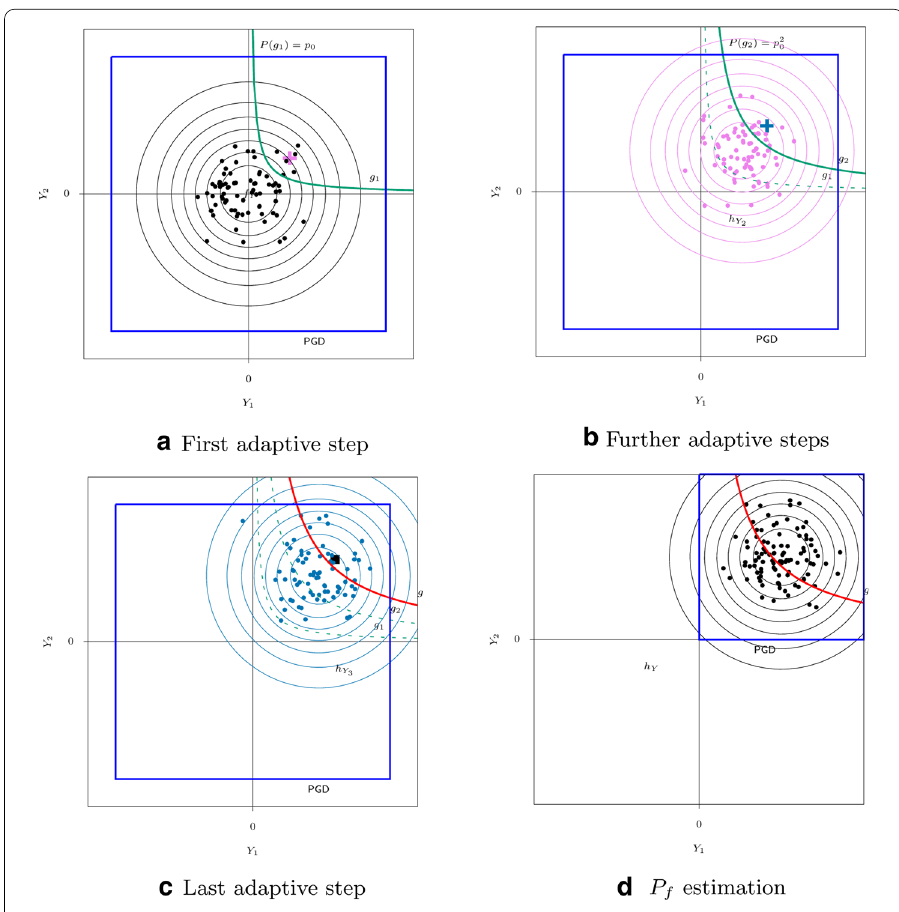
Fig. 2 PGD reliability analysis based on adaptive design point estimation a – c and the estimation of P f by means of importance sampling ( d